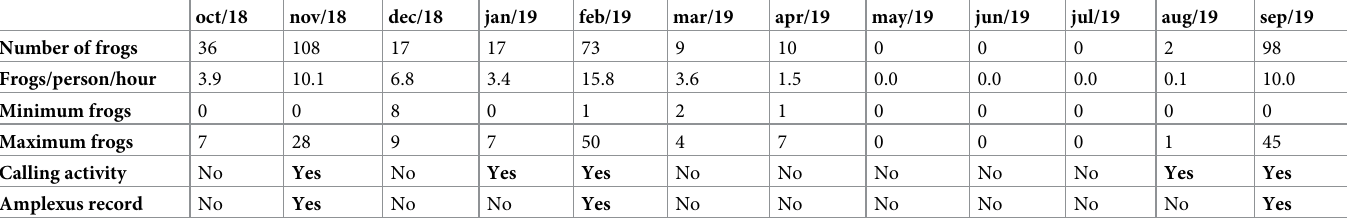
Table 3. Number of observations, calling activity and amplexus during one year of field survey for the study of Natural History of Brachycephalus rotenbergae sp. nov.